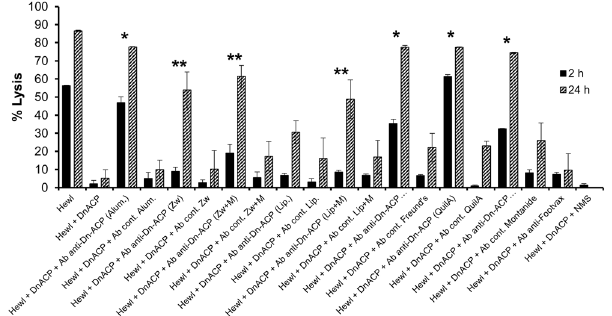
Figure 6. Effect on the levels of restored Hewl lytic activity, initially inhibited by rDn-ACP, influenced by the nature of the adjuvant used to generate antisera to rDn-ACP. Determination of percentage of M. lysodeikticus cell lysis for each test condition shown in Supplementary Fig. 7 for 2 h and 24 h incubation time points only. The columns represent the mean % lysis (from n = 3 independent experiments) and the error bars represent the corresponding SEM. Data were compared with a paired t -Test and the asterisks denote significant inhibition (P < 0.05) of rDn-ACP function by anti-rDn-ACP sera, compared to treatment without antisera, after 2 h (and continuing after 24 h incubation) ( * ) or after 24 h only ( **